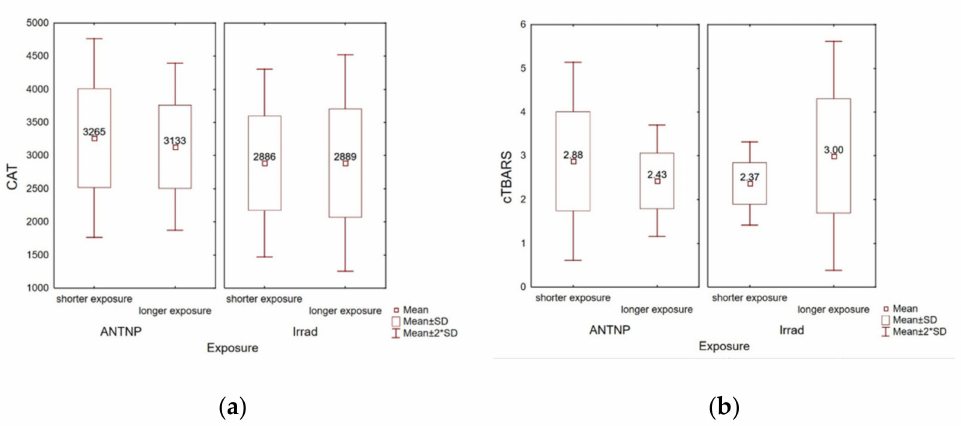
Figure 6. Correlation between the exposure time at work (in years) and oxidative stress parameters. ( a ) Catalase activity (U/g Hgb); ( b ) cTBARS (nmol of